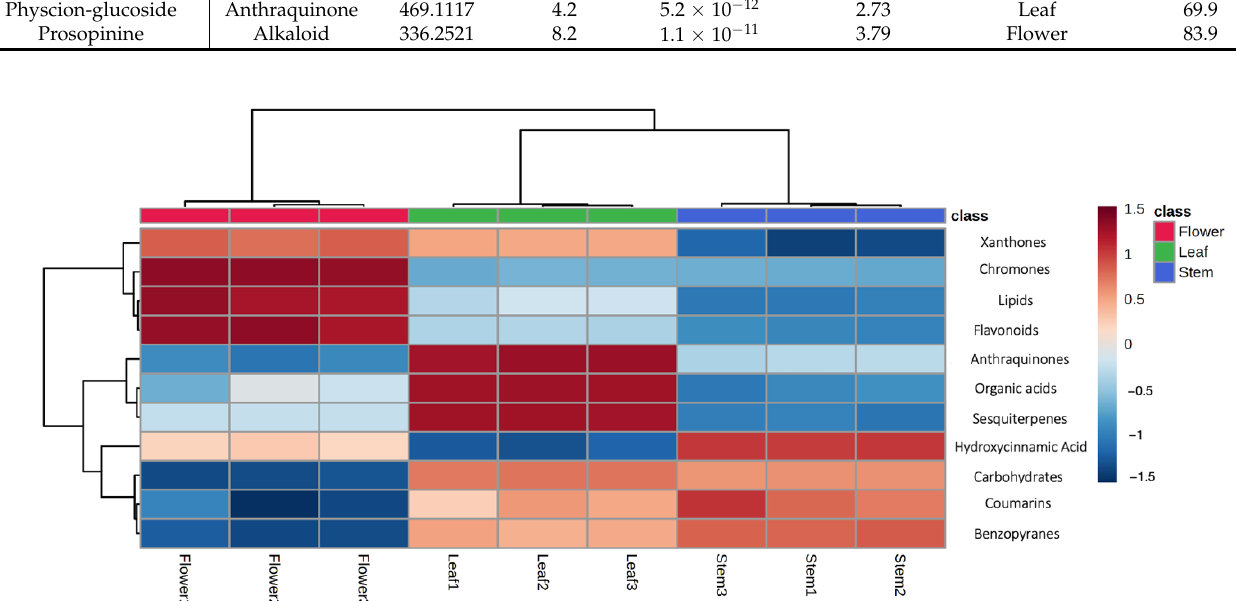
Figure 3. Hierarchical clustering analysis and heat map visualization obtained considering the three plant organs and using the metabolites annotated grouped in biochemical classes (distance: Euclidean; clustering algorithm: Ward).